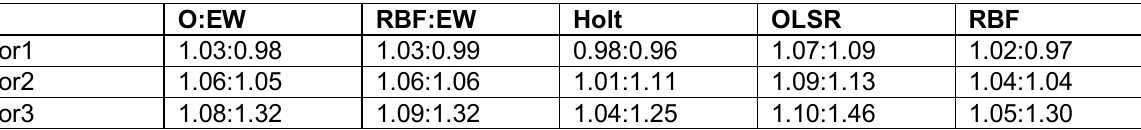
Table 6: RAE Profile of the Forecasting Models over the